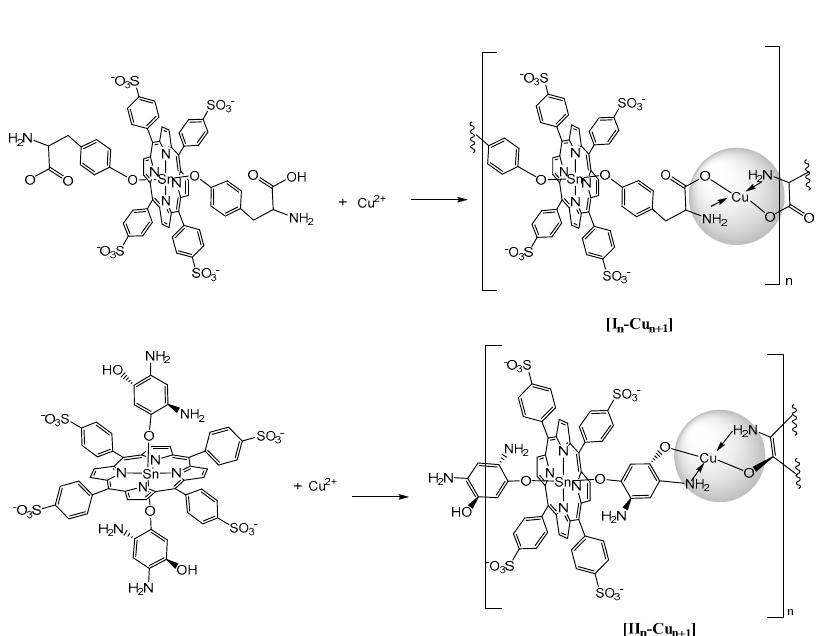
Figure 2. Proposed structures of products of the of the Sn(IV)-porphyrin axial complexes I and II interaction with Cu 2+ cations . Table 1. Geometric parameters of the studied compounds obtained by quantum-chemical calcula- tions using the Density-functional Theory DFT/CAM-B3LYP hybrid functional and 3–21g basis . Compounds I I-Cu-I II II-Cu-II The maximum distance from the upper point of the ligand to the porphyrin core,Å